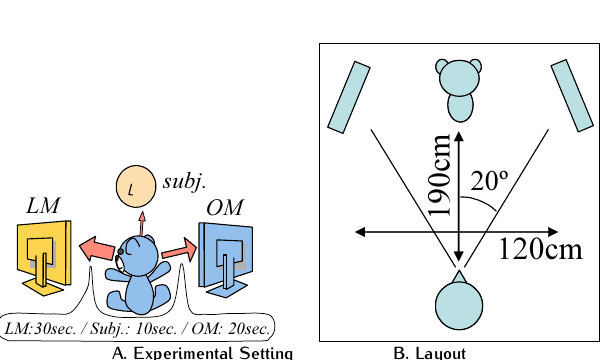
Figure 11. Setting and Layout of Experiments on Drawing Interest